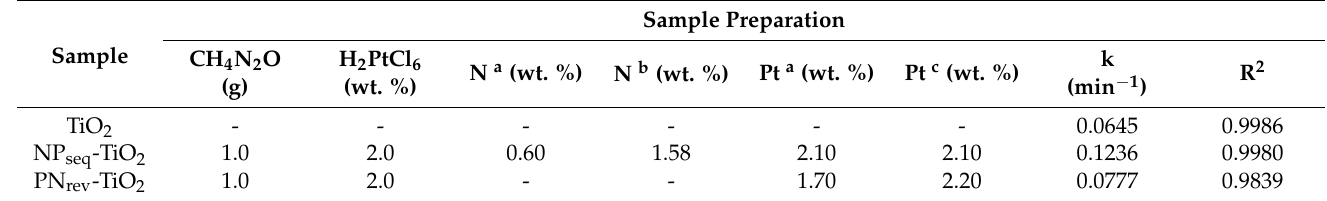
Table 2. The sample preparation and pseudo-first-order rate constant, k (min − 1 ), for photocatalytic degradation of 12 mg L − 1 of MB dye for TiO 2 , NP seq -TiO 2 , and PN rev -TiO 2 photocatalysts irradiated with 55-Watt fluorescent lamp for 60